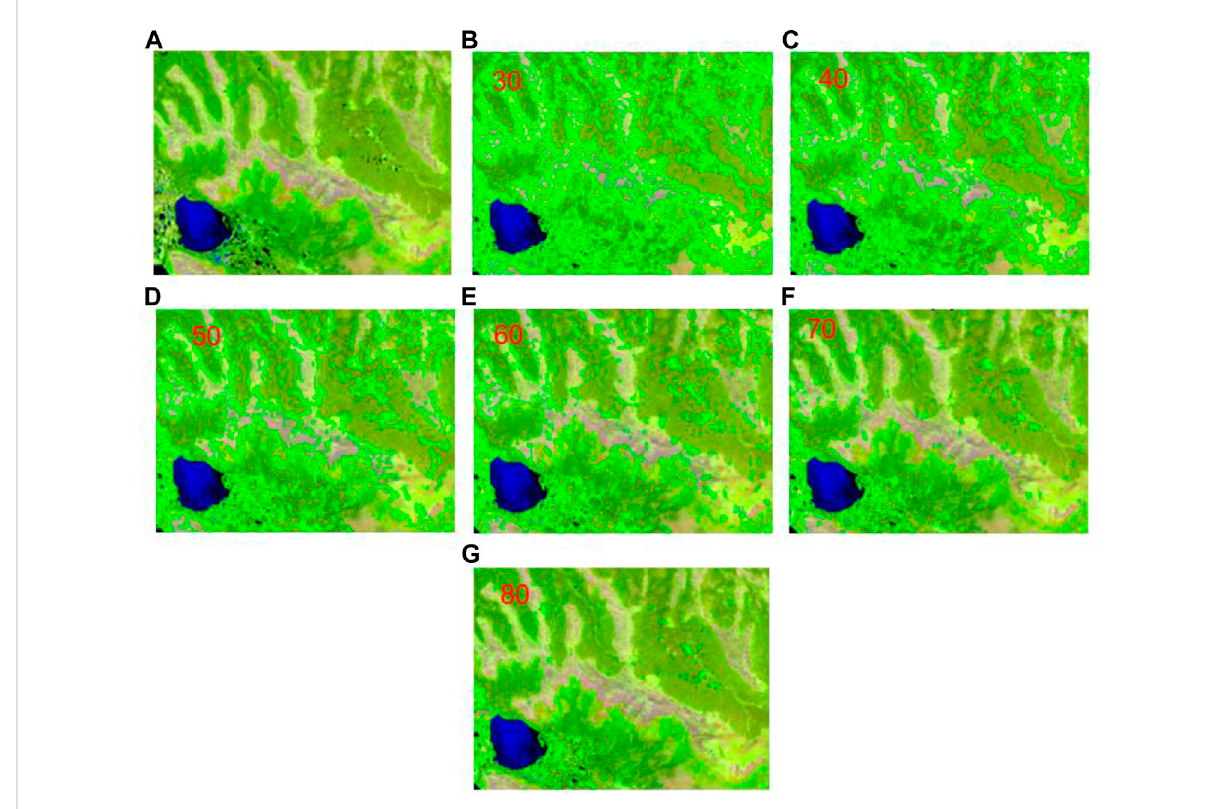
Comparison of segmentation results at different scales based on Landsat eight OLI; the background image is a Landsat eight OLI image composite from bands 7, 5, 3. (A) Original image. (B) Segmentation scale: 30. (C) Segmentation scale: 40. (D) Segmentation scale: 50. (E) Segmentation scale: 60. (F) Segmentation scale: 70. (G) Segmentation scale: